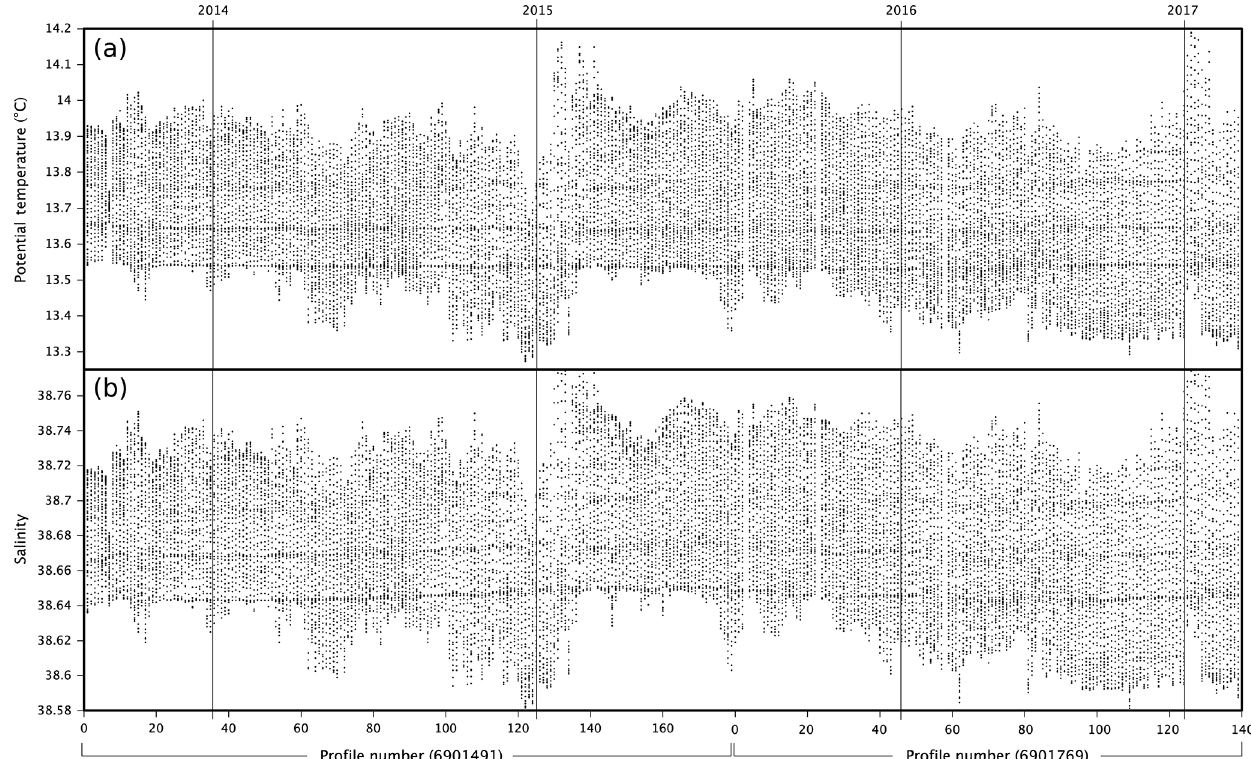
Figure 4. Temperature (a) and salinity (b) recorded between 300 and 1000dbar at a vertical resolution of 10dbar, by the consecutive deployments of floats 6901491 and 6901769 in the Tyrrhenian Sea. On the x axis, the number of successive profiles for each float with a resolution of 1 to 7d is indicated. The years of deployment are indicated by the vertical lines.